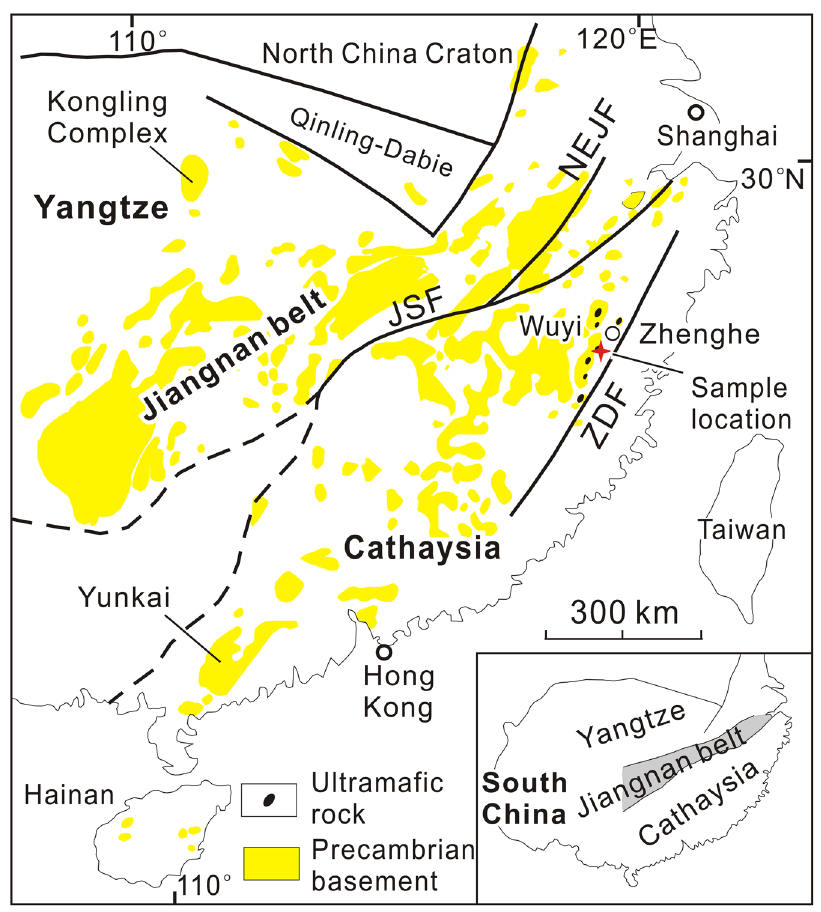
Figure 1. Simplified geological map of eastern South China (modified from Zhao and Cawood 52 ), showing the location of the honblendites.